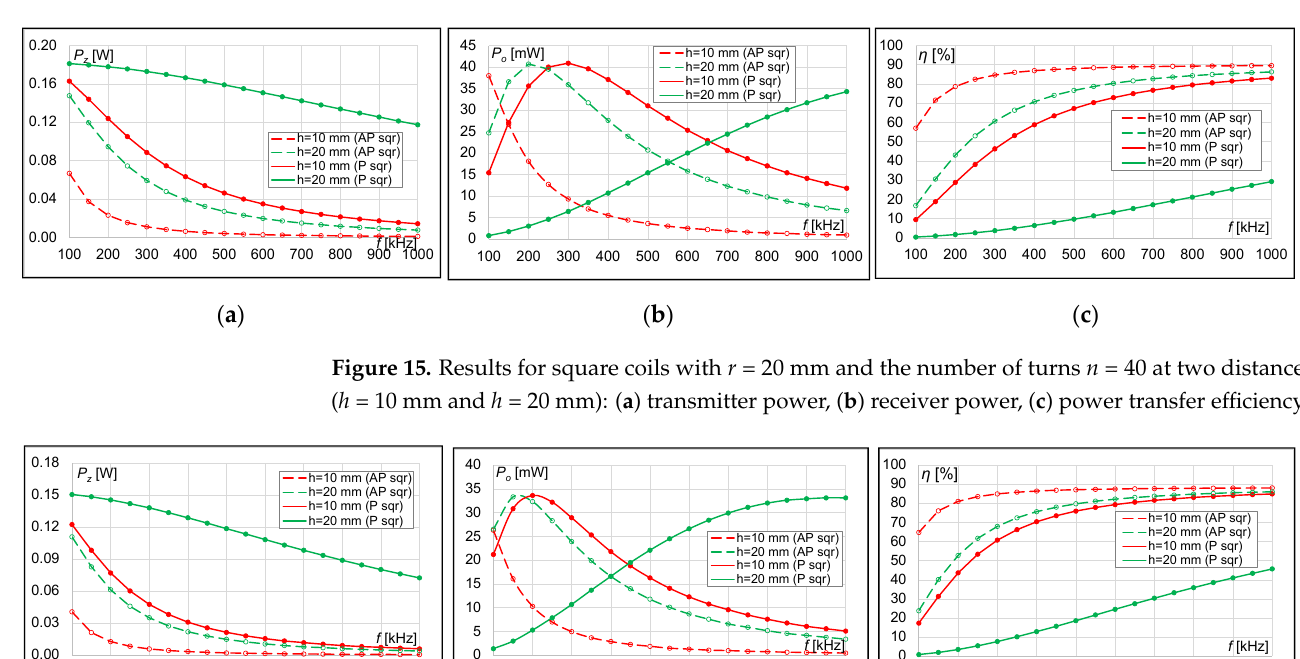
( c ) Figure 14. Results for square coils with r = 5 mm and the number of turns n = 25 at two distances ( h = 2.5 mm and h = 5 mm): ( a ) transmitter power, ( b ) receiver power, ( c ) power transfer efficiency. Regardless of the frequency, the efficiency of the system is comparable for two mod- els: periodic at h = 2.5 mm and aperiodic at h = 5 mm (Figures 12c, 13c, and 14c). Regardless of the number of turns, the highest efficiency of the system is for the aperiodic model at h = 2.5 mm, e.g., for the number of turns n = 25, the efficiency of the system is 75% at the frequency f = 1 MHz (Figure 14c). The highest difference in efficiency between aperiodic and periodic models occurs at n = 15 and h = 2.5 mm and reaches 47% (Figure 12c).